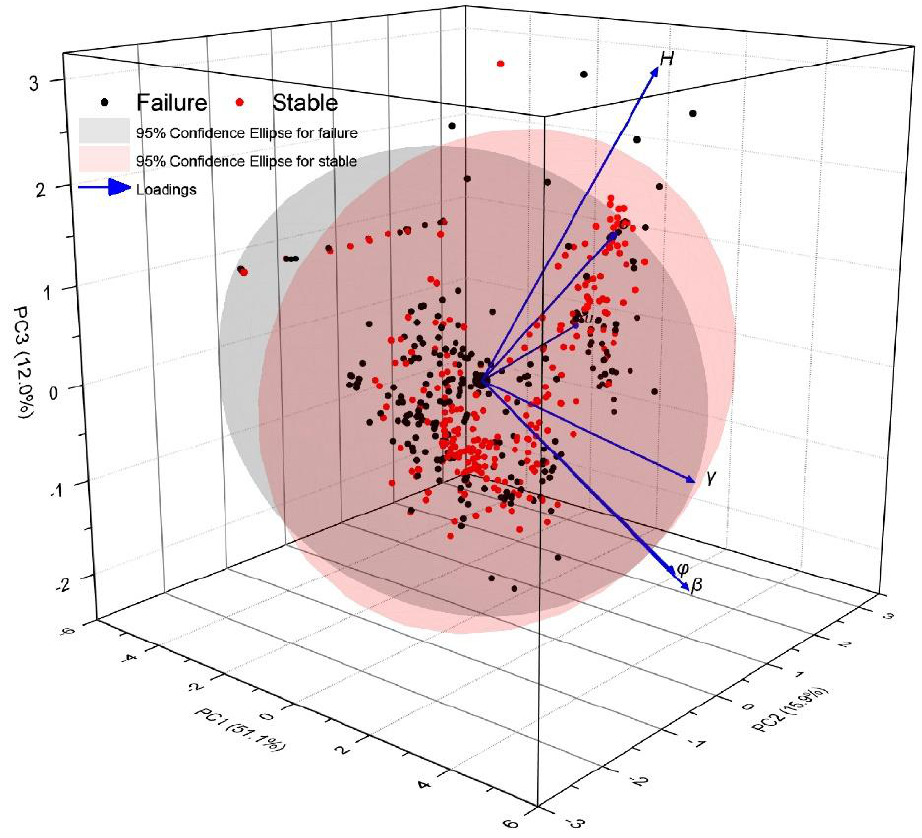
Figure 2. Scatter matrix showing the collected dataset. The panels in the upper right show the data points, and the lower left half of the figure shows the correlation coefficients between the features and the slope stability status.